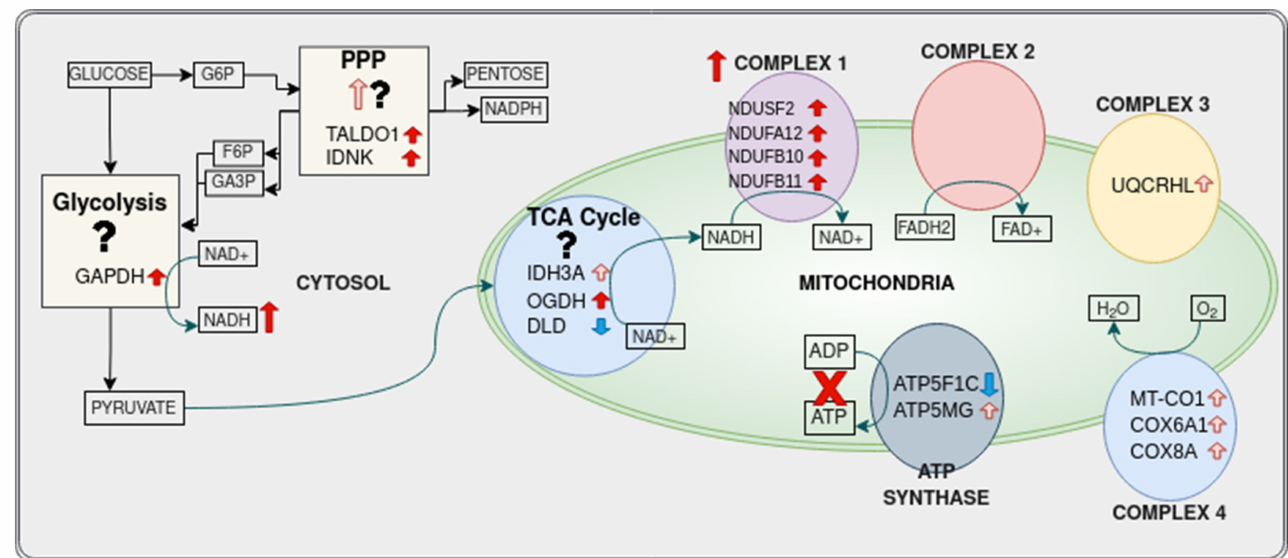
Figure 16. Differential expression of enzymes involved in glycolysis, pentose phosphate pathway, TCA cycle and oxidative phosphorylation in RA CD8 + Tem cells. Solid red UP arrows indicate upregulation/increased activity. Solid blue down arrows indicate downregulation. Light red arrows indicate statistically significant upregulation with low read counts. Pathways where the overall effect of differential regulation on the activity of the pathway is ambiguous are marked by a question mark. PPP—pentose phosphate pathway; G6P—glucose-6-phosphate; F6P—fructose-6-phosphate;